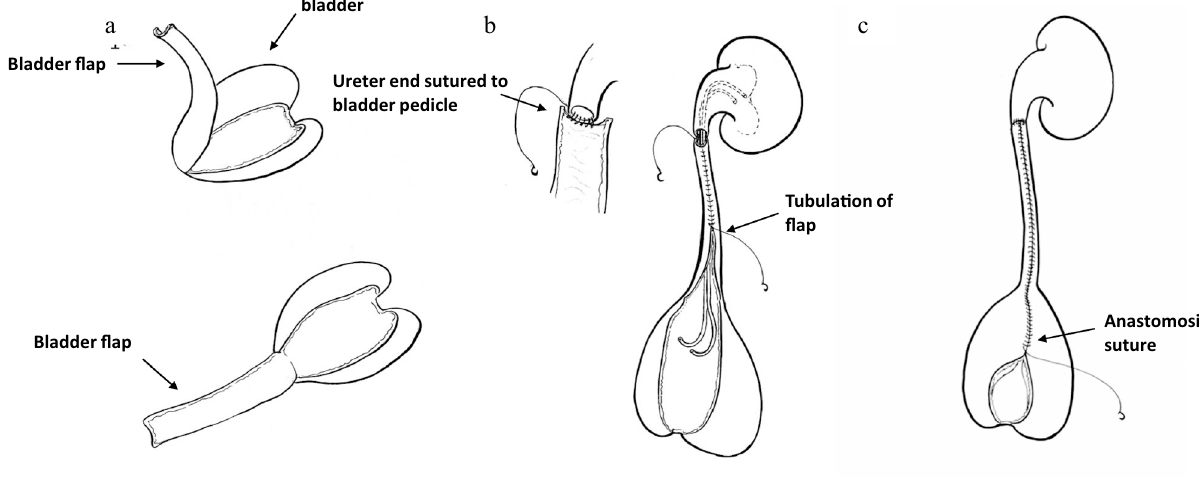
Figure 2. Schematic diagram of the surgery. ( a ) bladder flap taking, ( b ) ureter Reconstruction, ( c ) anastomosis from PUJ to UVJ.